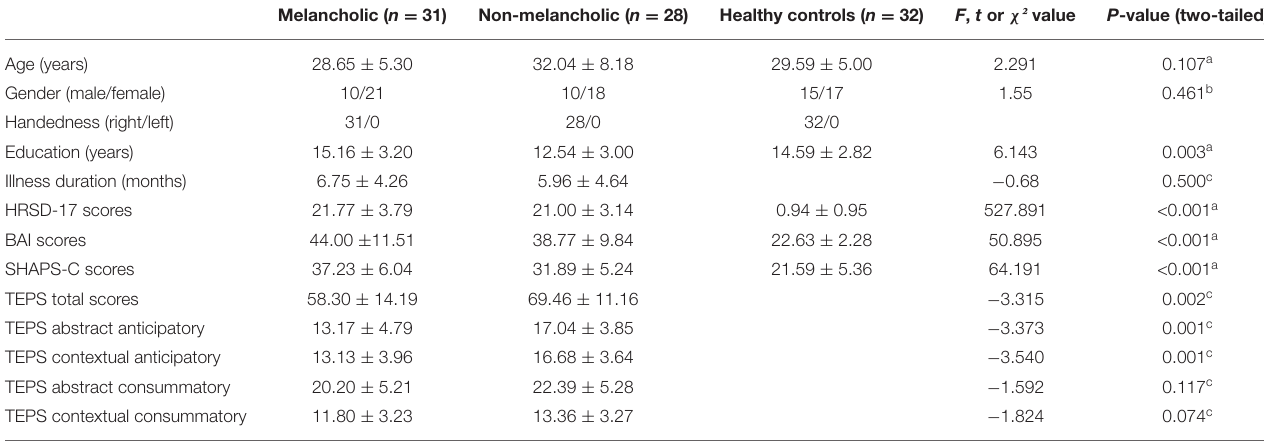
TABLE 1 | Demographic and clinical characteristics of the